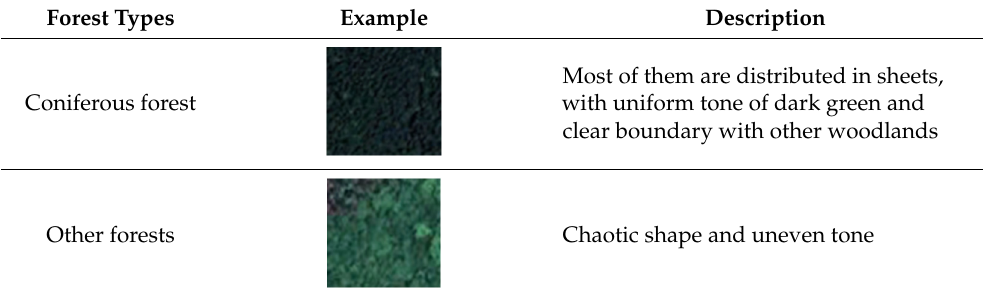
Table 1. Interpretation characteristics of forest types from Google Earth Pro high-definition images.